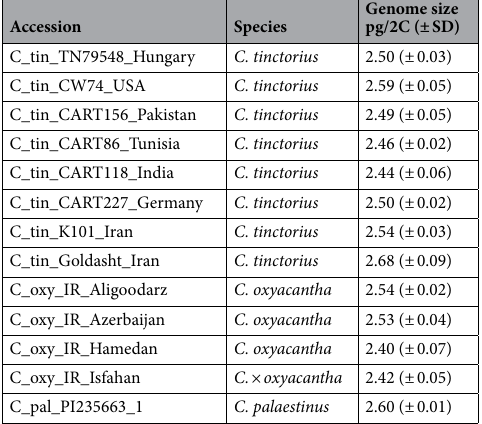
Table 1. Genome sizes of C. tinctorius , C. oxyacantha , and C. palaestinus individuals measured by flow cytometry against tomato cv. ‘Stupicke’ (2C = 1.96 pg) as size